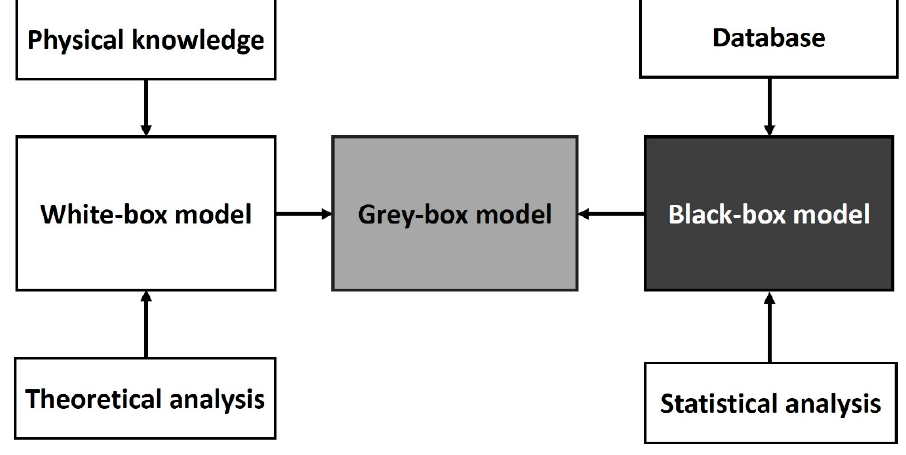
Figure 2. Gray-box model [19].